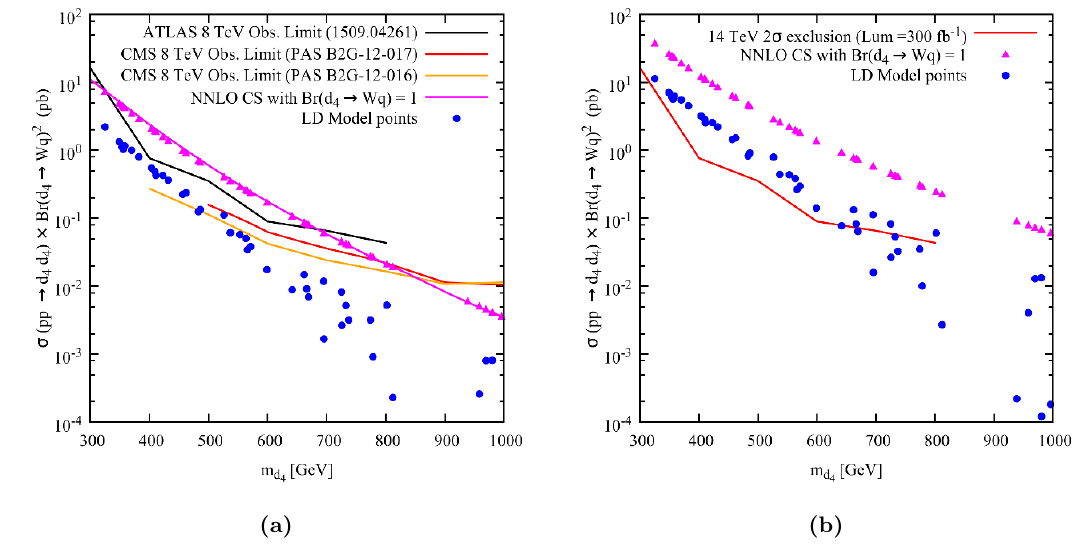
Figure 12. (a) A survey of collider constraints for the LD model in the plane ( d 4 , (cid:27) W (cid:6) q ) 2 ). Points are excluded above the solid yellow line. (b) Solid red line gives our projected exclusion bound at 14 TeV, 300 fb (cid:0) 1